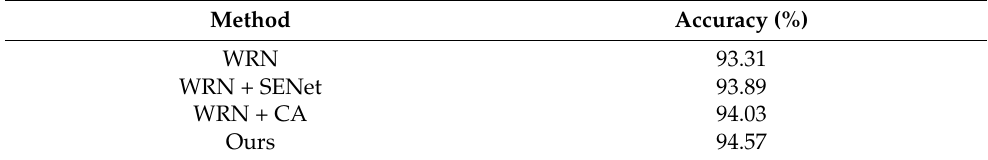
Table 1. Ablation test